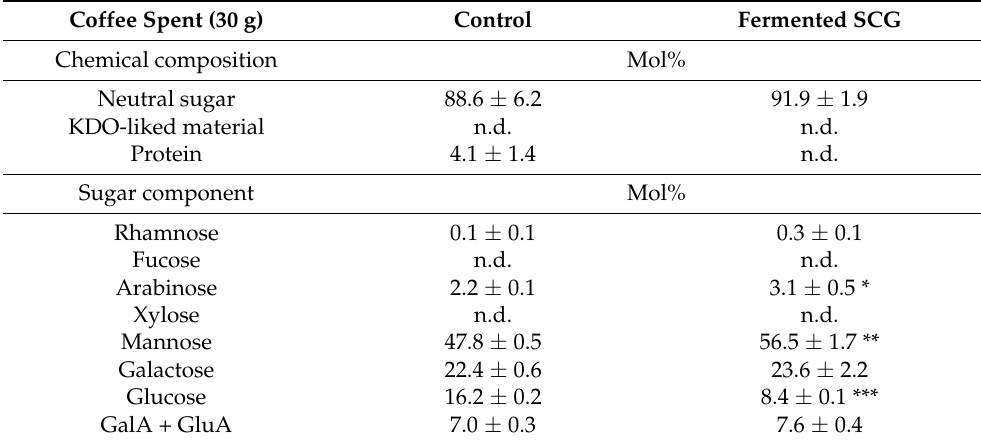
Table 4. Chemical properties of the crude polysaccharides isolated from the fermented SCG after 8 days of submerged culture.